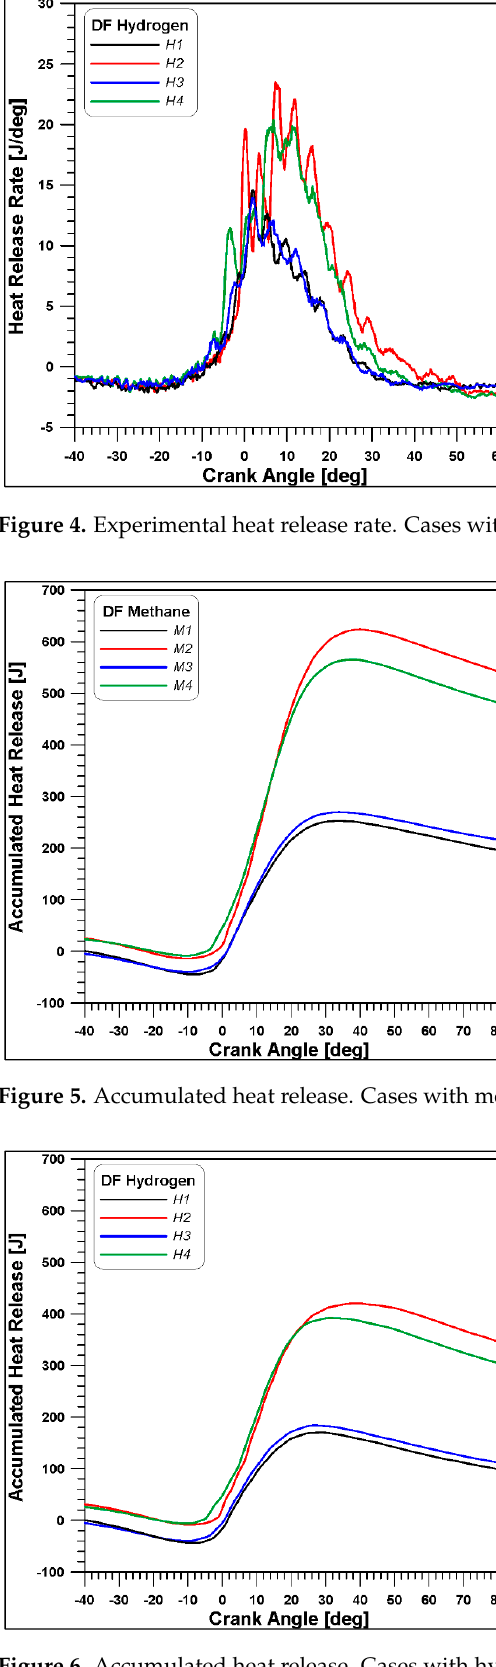
Figure 6. Accumulated heat release. Cases with hydrogen.